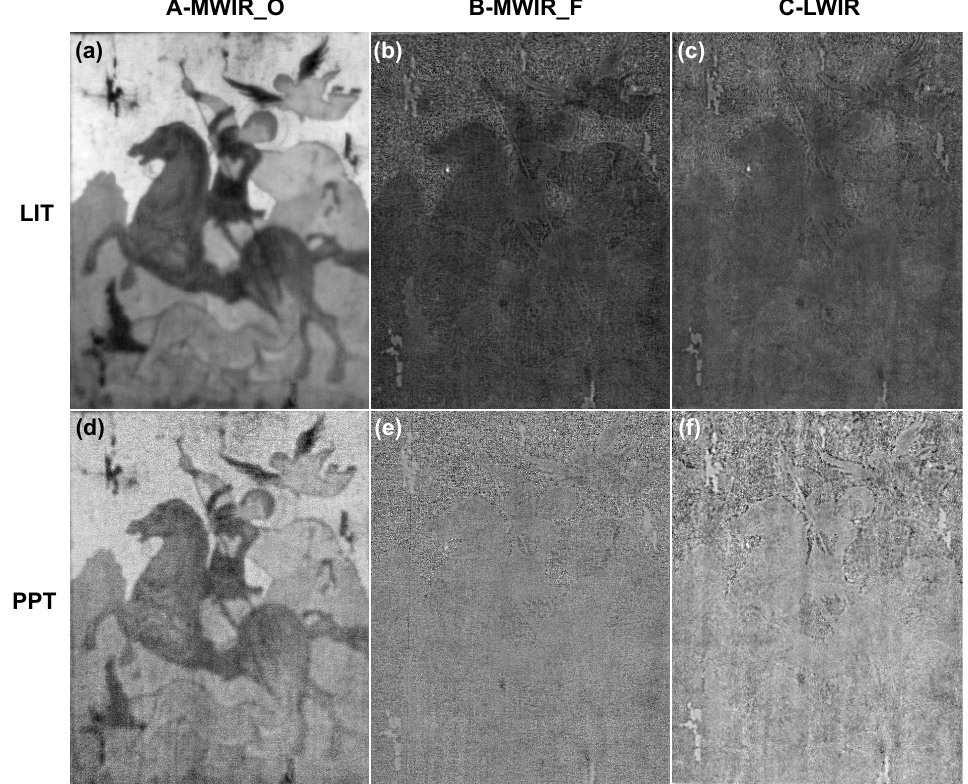
Figure 4. LIT and PPT phase images of the St George painting for all camera setups. Both LIT and PPT measurements were heavily influenced by reflections from the halogen lamps ( a , d ). The influence of these reflections was eliminated when using a long-pass filter ( b , e ) and the results look very similar to those of the LWIR camera ( c , f